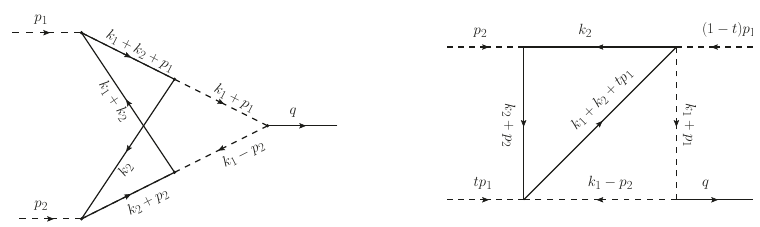
Figure 1 . Non-planar elliptic vertex on the left and effective diagram obtained by combining two propagators with Feynman parameter on the